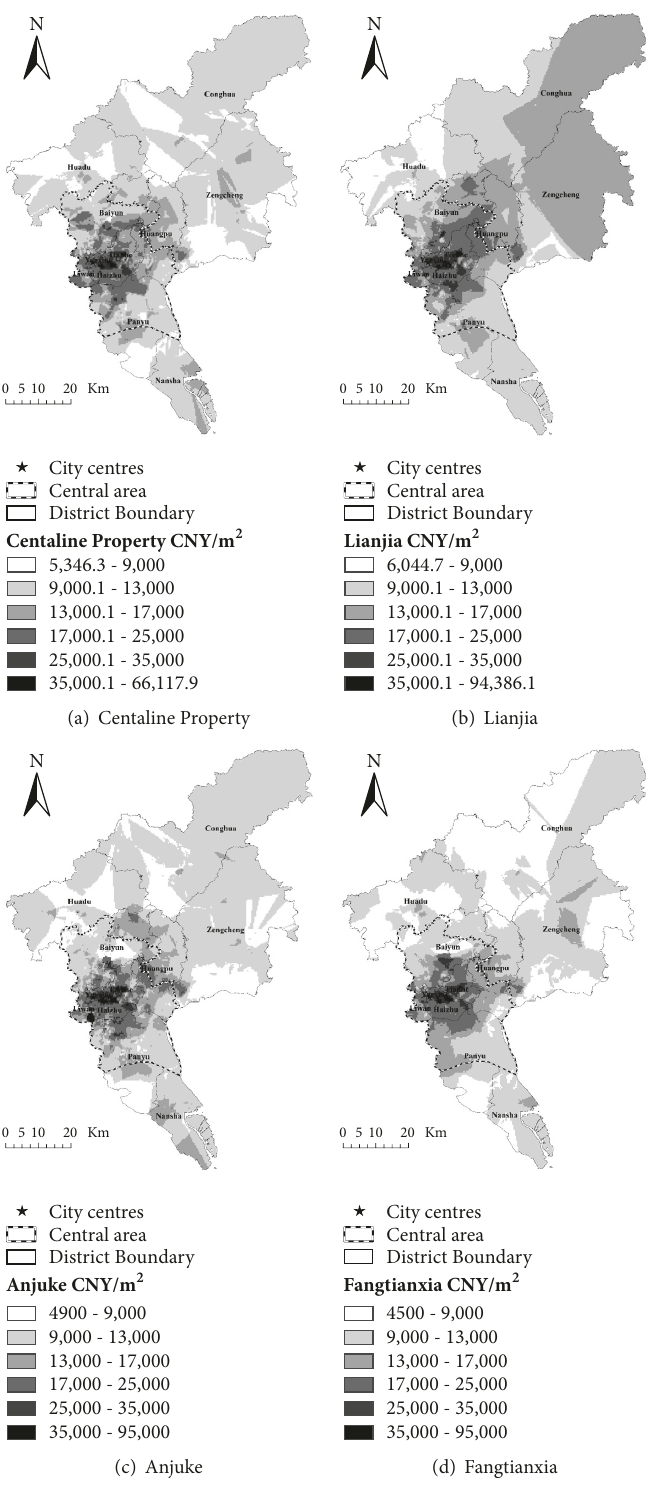
Figure 7: Spatial interpolation of second-hand residential housing prices in